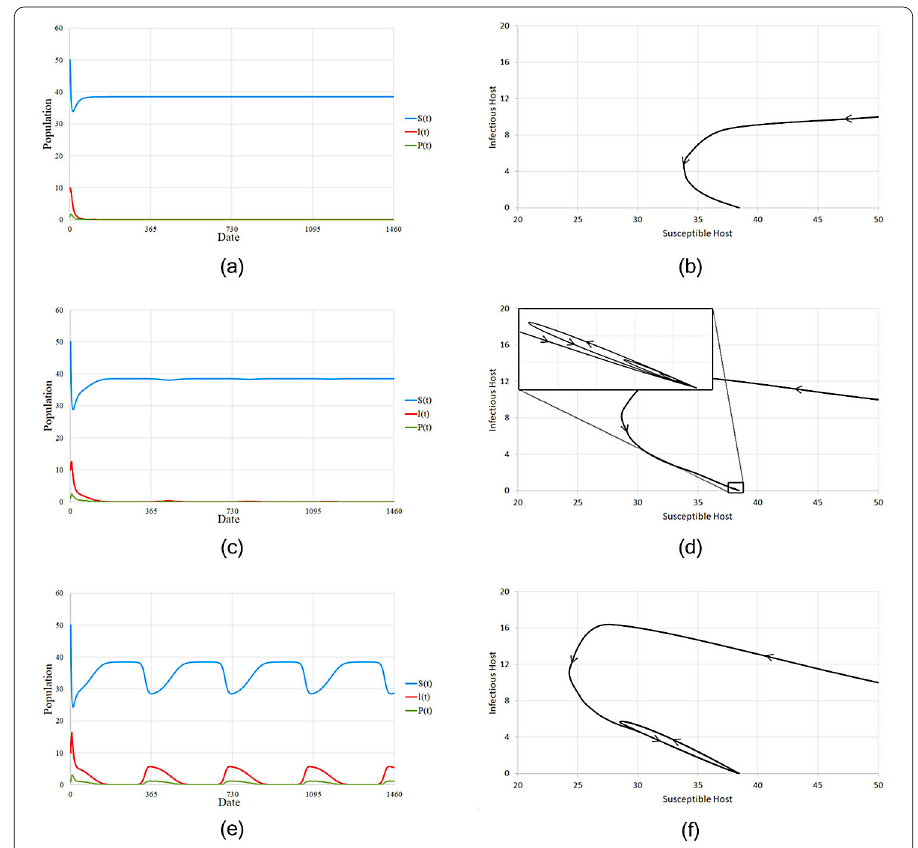
Figure 7 Numerical results in forced SISP model. Figures ( a ), ( c ), ( e ) are time-series plots, while (b,d,f) are phase plane plots of system (2). The forced parameters ω of ( a ), ( b ), ( c ), ( d ), and ( e ), ( f ) are 0.05, 0.30, and 0.55, respectively. The model’s parameters are as follows: β min = 0.01, δ min = 0.02, α = 0.40, μ = 0.13, m = 0.10, and γ =